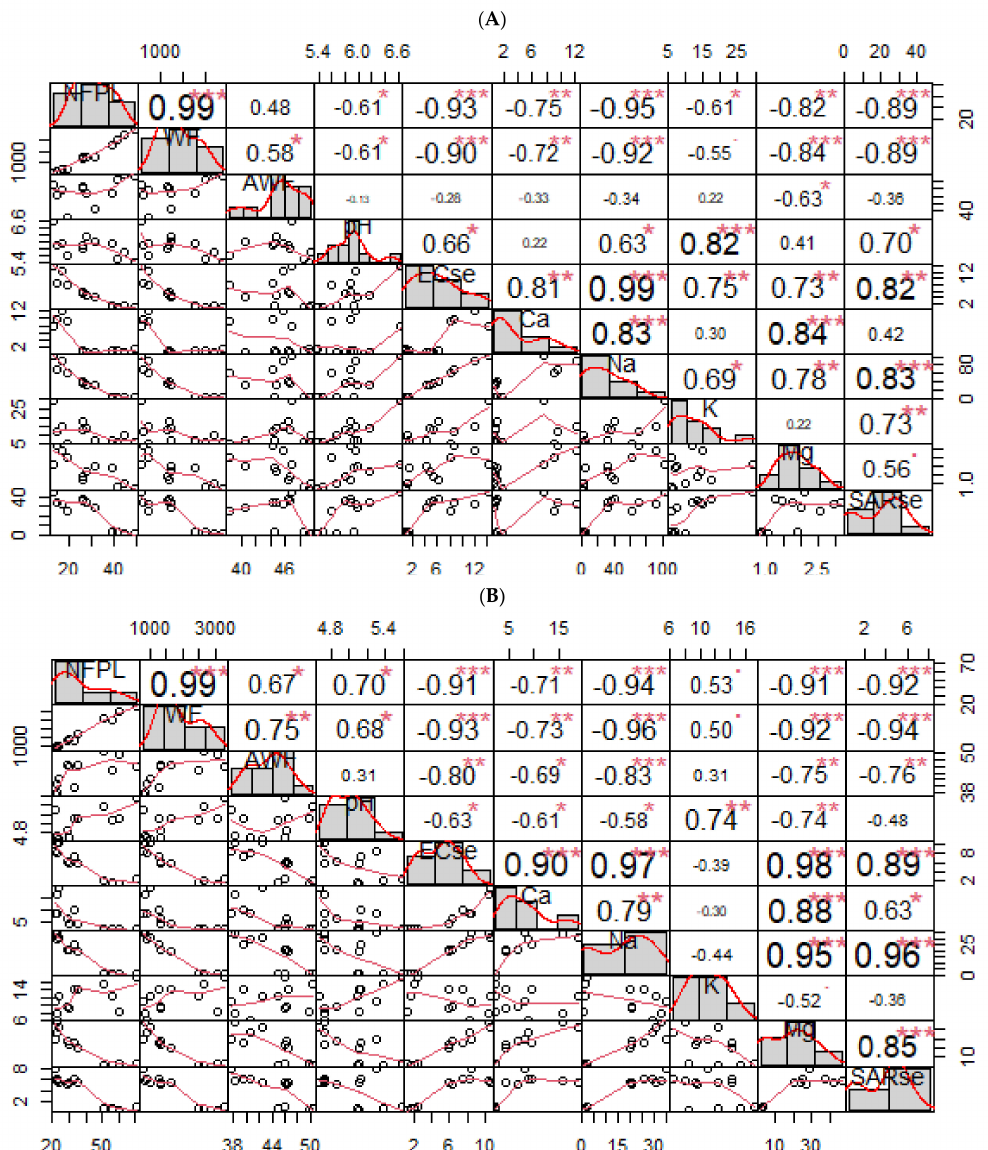
Figure 7. Analytical performance of Pearson correlation matrix of production variables (number of fruits per plant (NFPL), weight of fruits (WF), and average weight of fruit (AWF)) of genotypes studied under different water salinity levels, with the chemical characteristics of the soil saturation extract (pH, Ca +2+ , Mg 2+ , Na + , K + , ECes, and SARse) in the first ( A ) and second years ( B ). · , *, ** and *** = significant at 0.1, 0.05, 0.01 and 0.001 probability level,